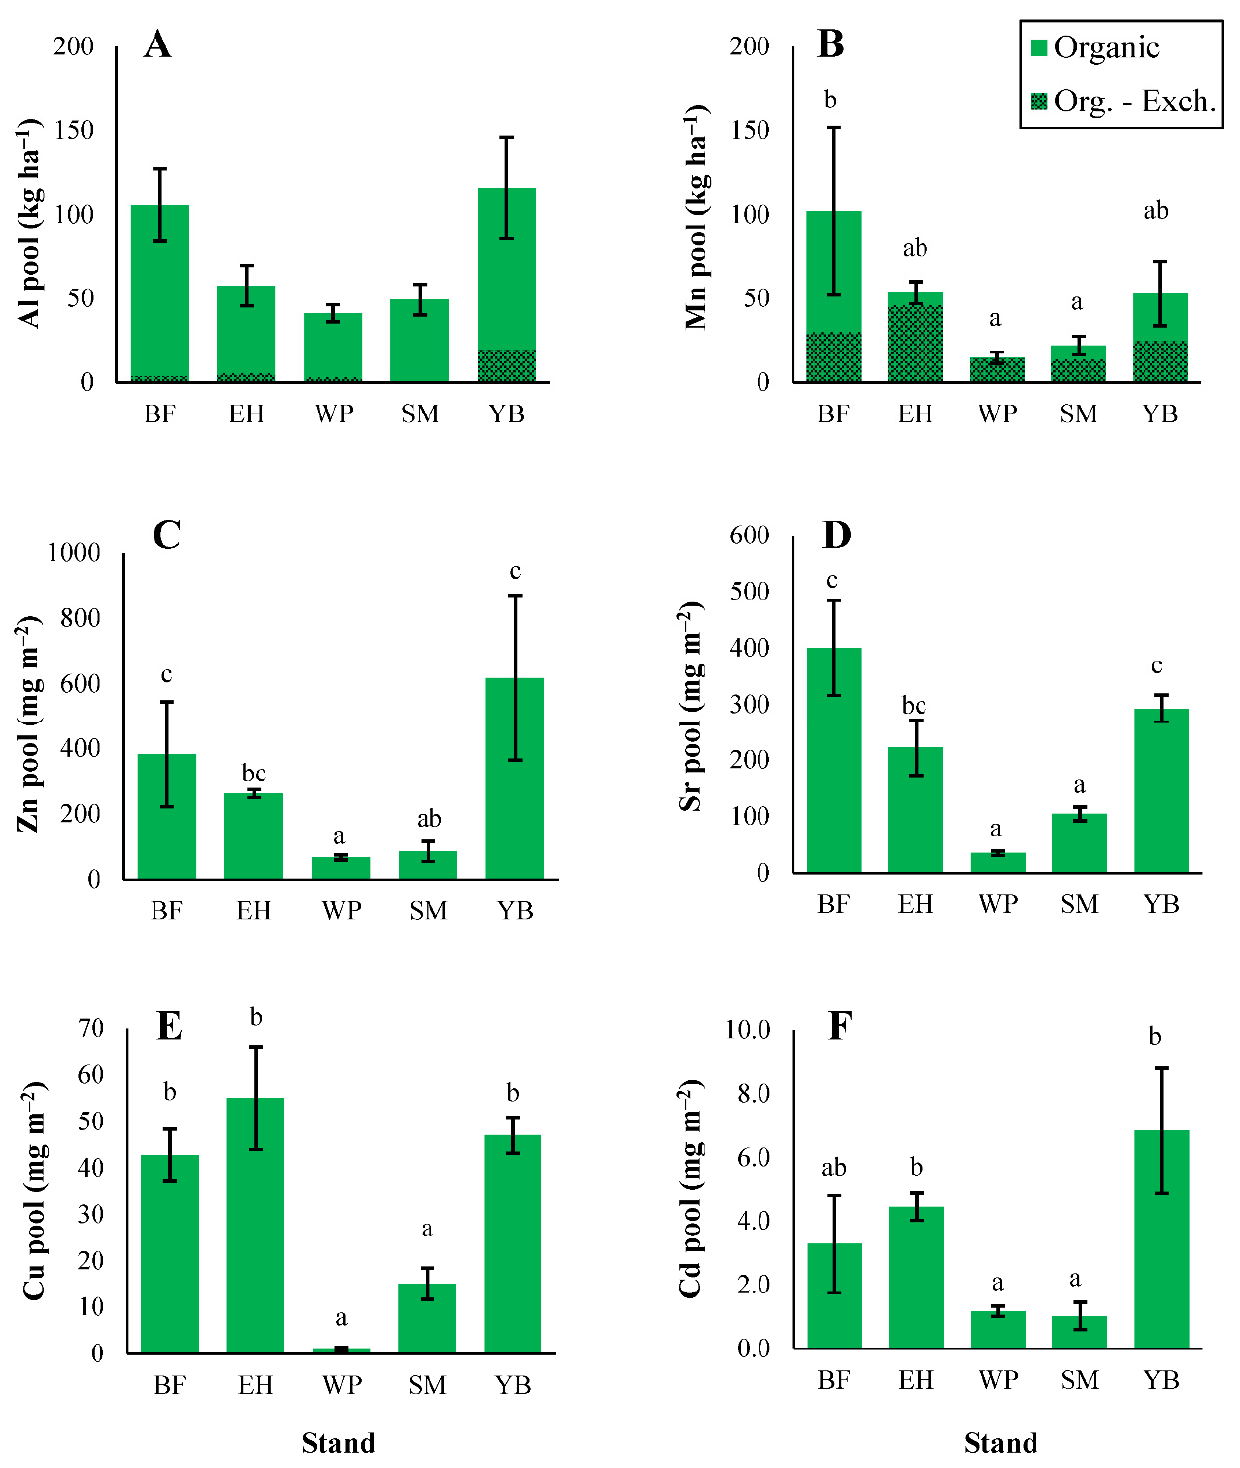
Figure 6. Organic horizon soil pools of aluminum ( A ), manganese ( B ), zinc ( C ), strontium ( D ), copper ( E ), and cadmium ( F ). Different letters indicate significant differences ( p < 0.05) in organic elemental pools among stands; where letters are not present, significant differences do not exist. ANOVA test results shown in Table S10. Exchangeable pools are also shown for aluminum and manganese (darker green). Error bars indicate S. E. For BF, EH, and YB, n = 3. For SM and WP, n = 5.